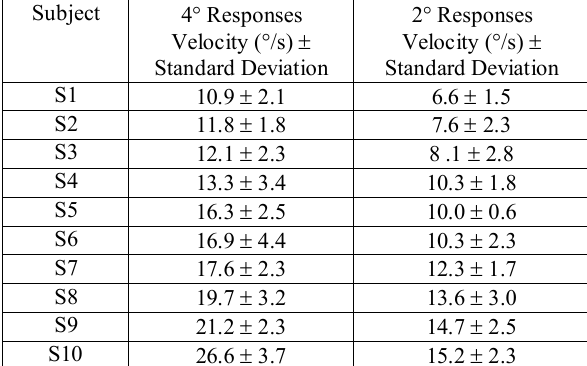
Table 1: Peak Velocity with one standard deviation from 10 Subjects to 4  and 2  symmetrical disparity step stimuli.